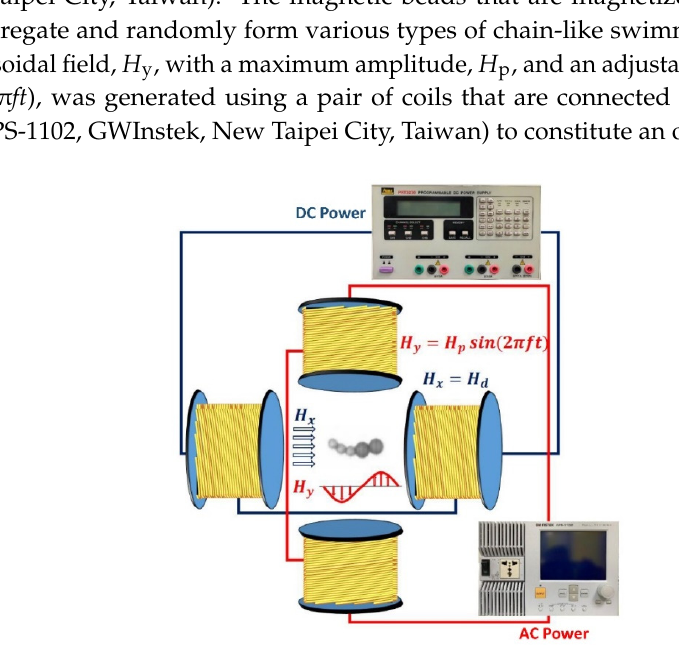
Figure 1. A schematic diagram of the experimental setup. A static directional magnetic field powered by a DC source was initially applied to create a linear microswimmer. An additional sinusoidal dynamic field from an AC power supply was then applied perpendicularly to generate an oscillating field, which created a waggling motion for the magnetic microswimmer.